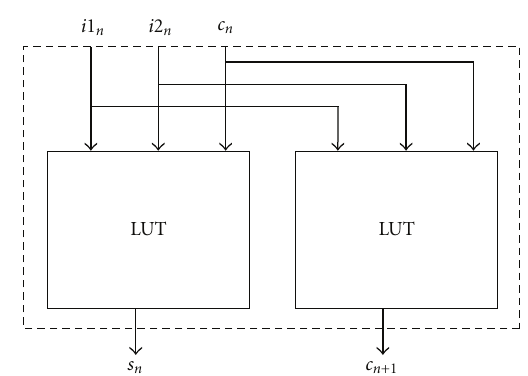
Figure 3: Optimized elementary cell for three-to-four-input